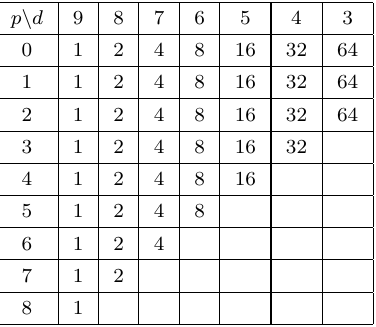
Table 24 . Number of D-branes in the p -brane multiplet in d -dimensions [10]. p \ d